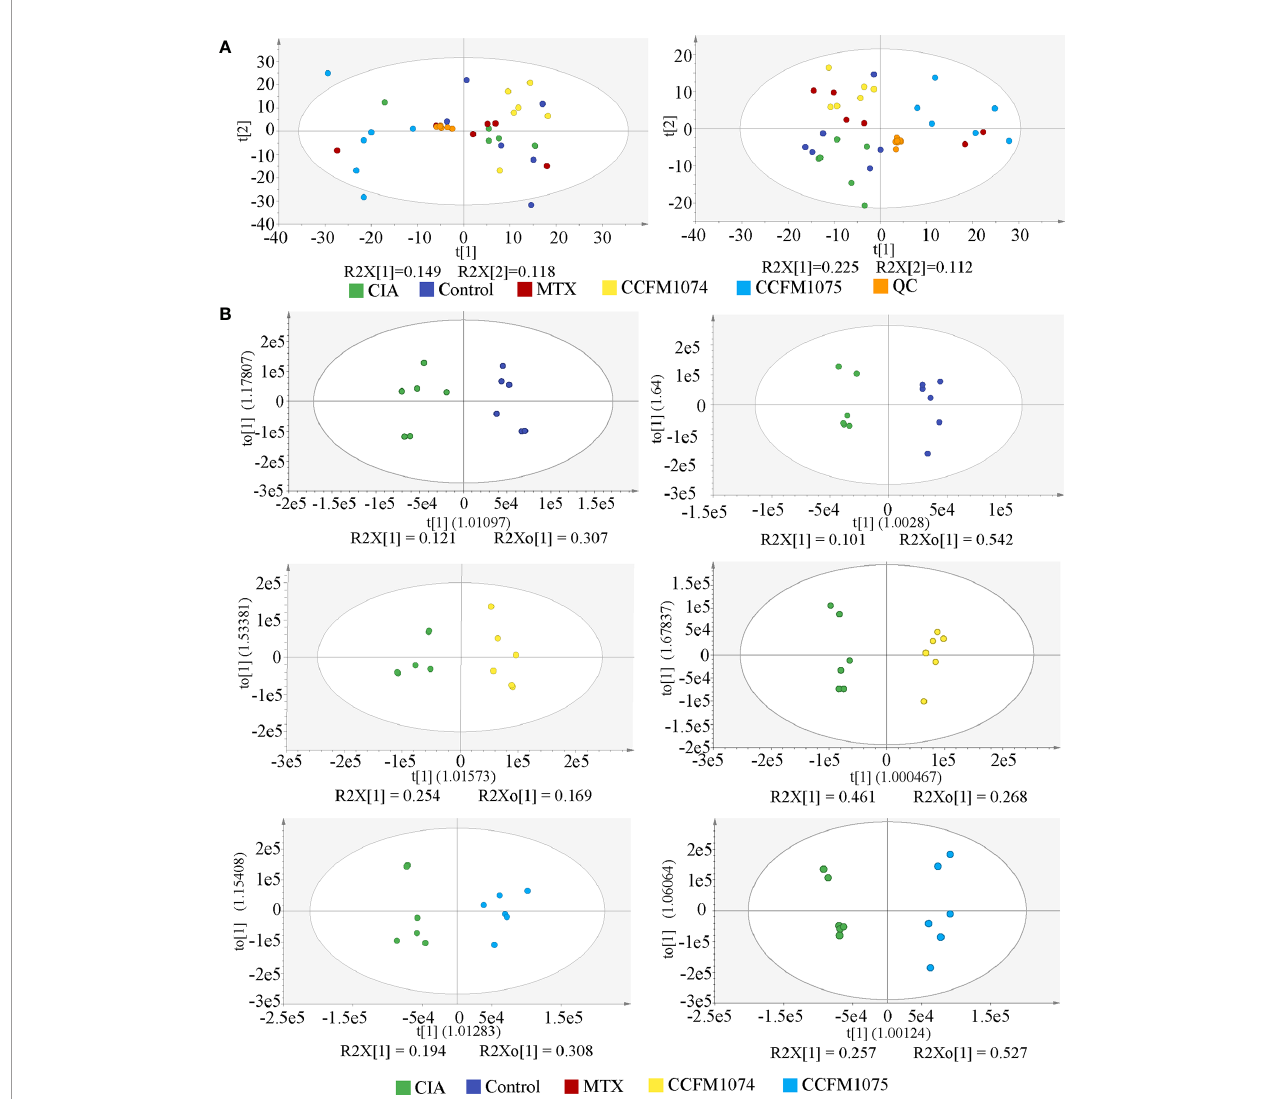
FIGURE 6 | The PCA and OPLS-DA score plots of plasma samples among groups. (A) PCA score plots in ESI+ model (left panel) or ESI- model (right panel). (B) OPLS-DA score plots between two groups in ESI+ model (left panel) and ESI- model (right panel). control (vehicle-treated with saline 1.5 mL/day) group, CIA (vehicle-treated with saline 1.5 mL/day) group, methotrexate (MTX)-treated (6 mg/kg/week) group, CCFM1074 (treated with CCFM1074, 8.5 × 10 9 CFU/day) group and CCFM1075 (treated with CCFM1075, 8.5 × 10 9 CFU/day) group, eight rats per